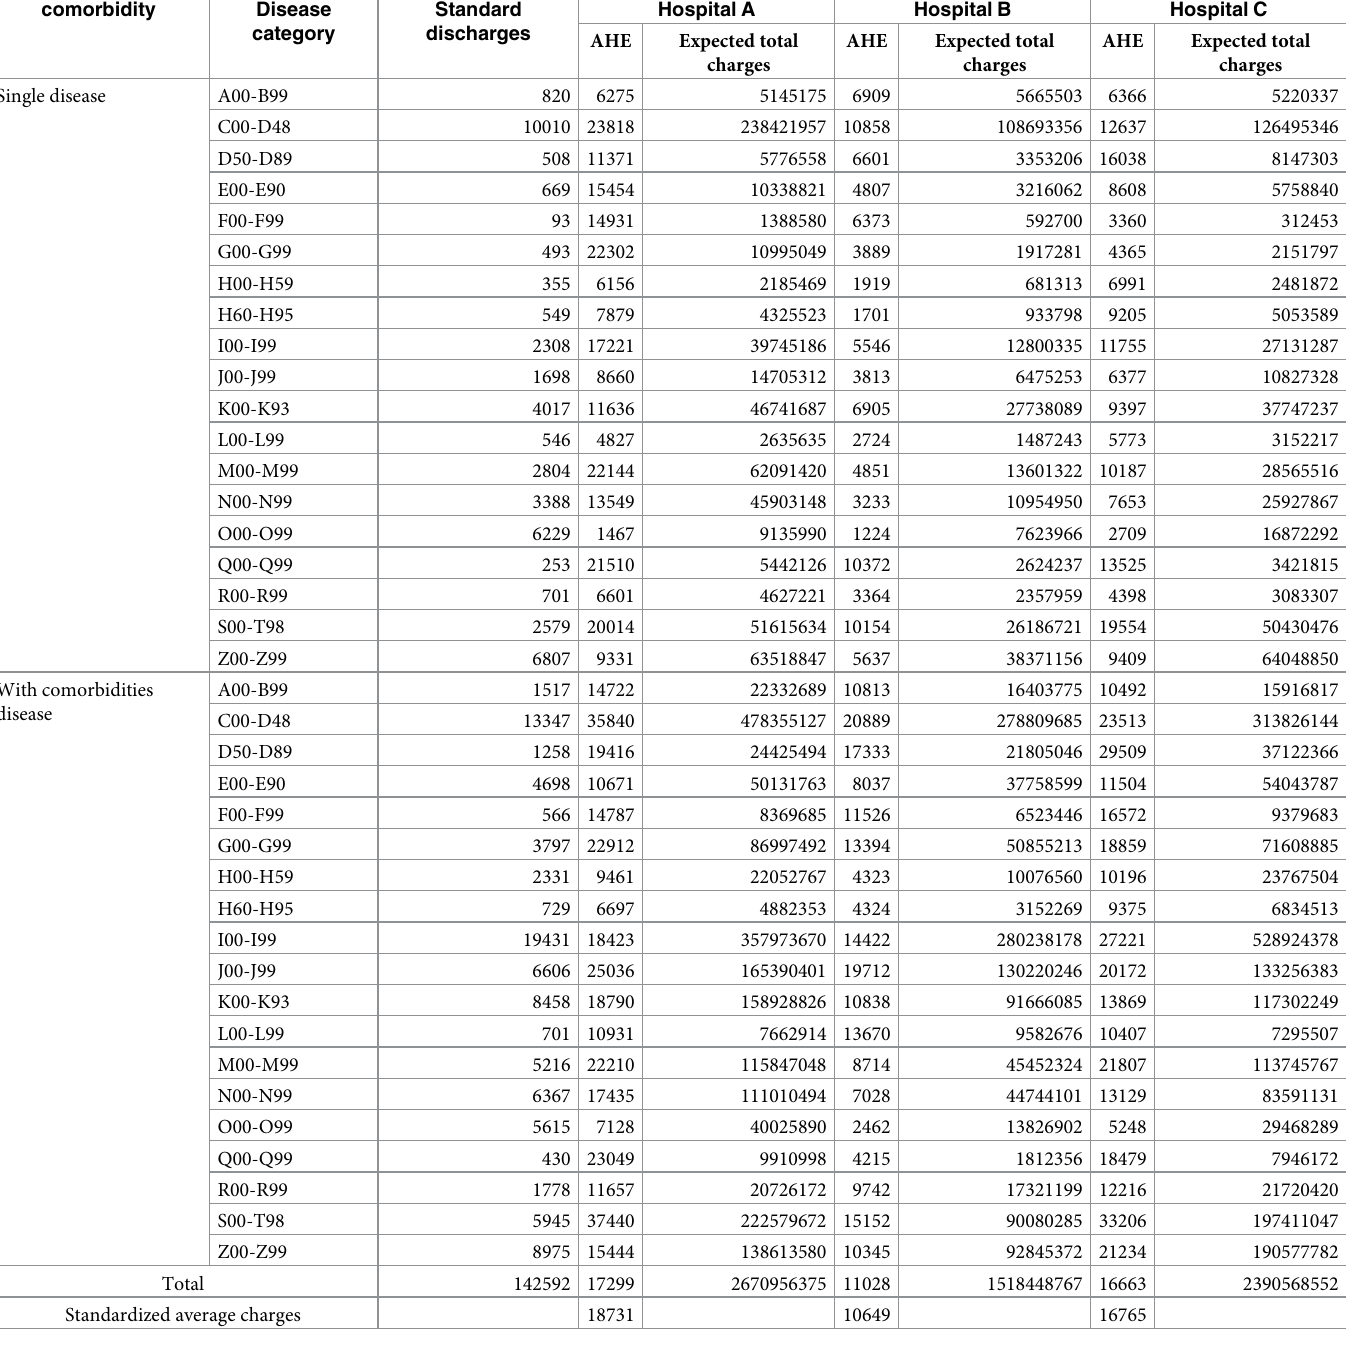
Table 9. The standardized AHE by disease category and comorbidity among three hospitals (CNY).